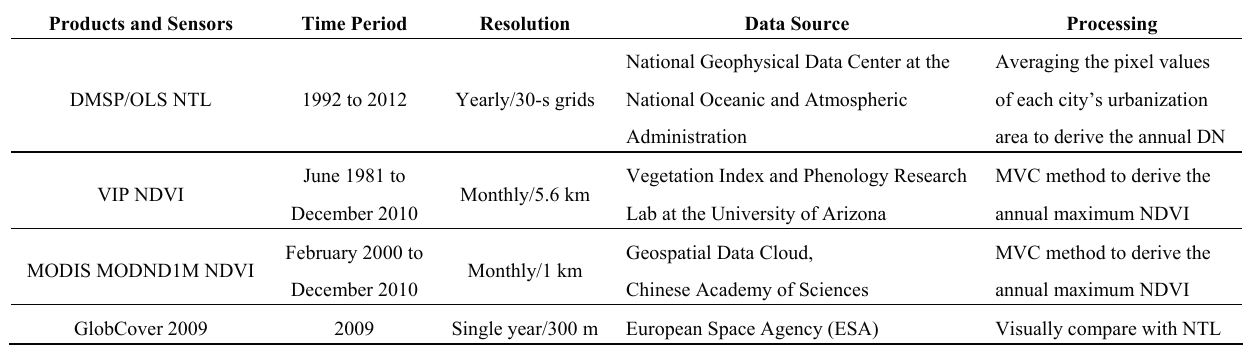
Table 1. Data specifications of the four data sets adopted in this study.